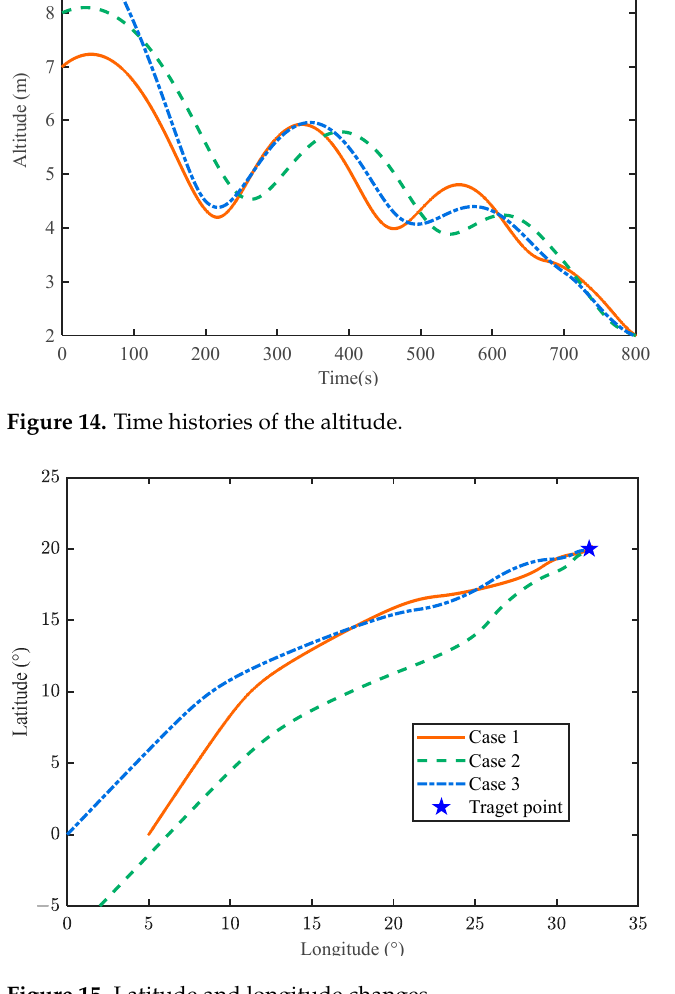
Figure 15. Latitude and longitude changes.